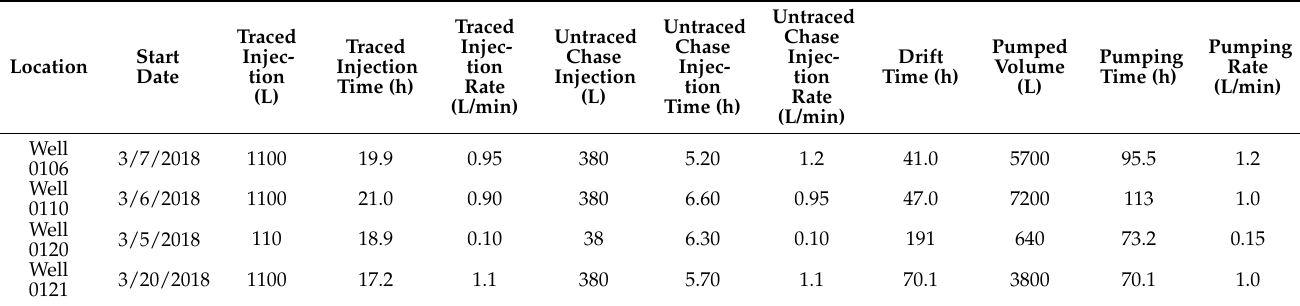
Table 1. Push–Chase–Drift–Pull Testing